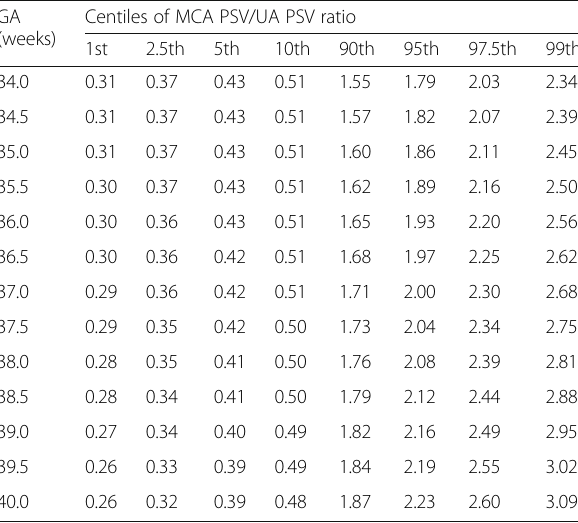
Table 2 Gestational age-defined reference ranges for MCA